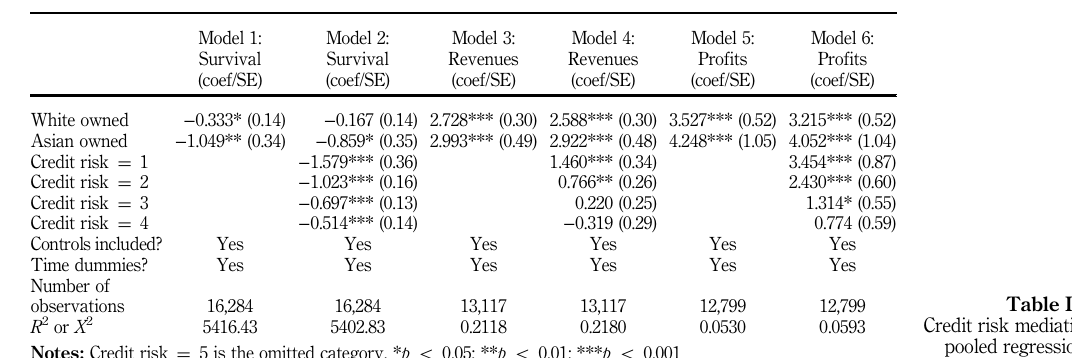
Table VIII. Assets mediation pooled regressions